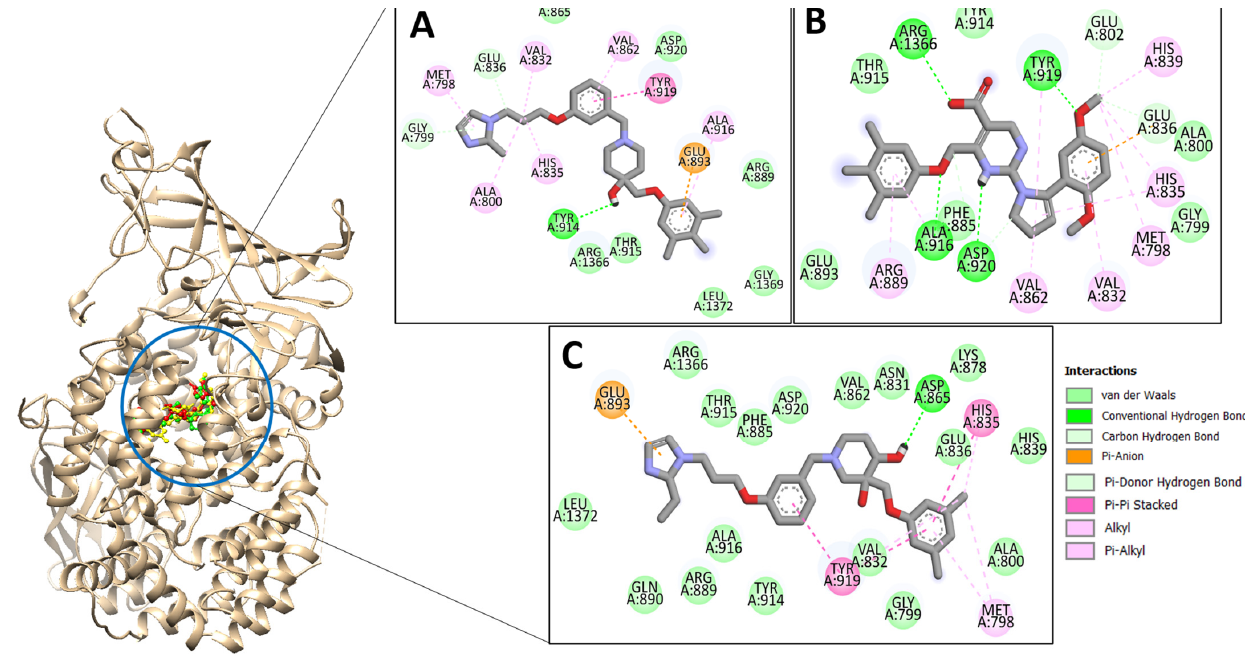
Figure 1. Docking conformation of compounds (shown by color ball and sticks) with TgAPN2 (shown by solid cartoon ribbon). ( A ) LAS_52160953, ( B ) LAS_51177972, and ( C )